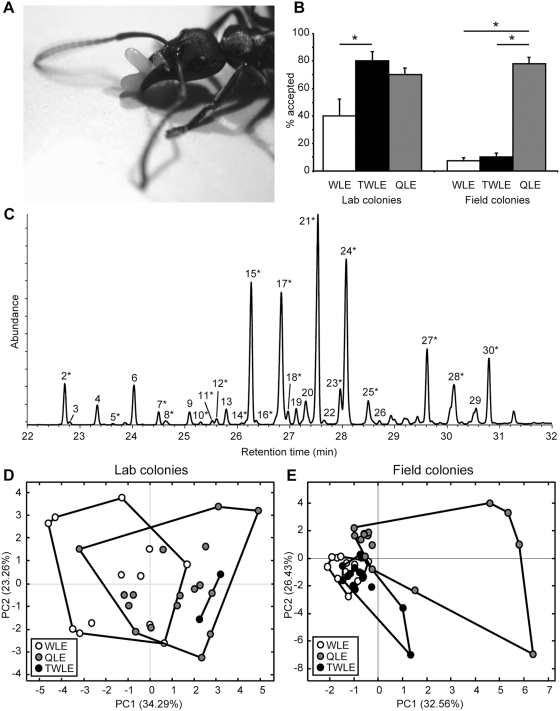
The effect of 3,11-diMeC27 on the acceptance of eggs in discriminator colonies and on the overall chemical profile.(A) A worker of Pachycondyla inversa carrying eggs. (Photo by M.A. Fürst and J.S. van Zweden). (B) The average acceptance rates in discriminator colonies (±S.E.) of sham-treated worker-laid eggs (WLE), worker-laid eggs treated with 3,11-diMeC27 (TWLE), and sham-treated queen-laid eggs (QLE) in lab and field colonies; * indicates p<0.05 (GLZ, see text). (C) A typical hydrocarbon profile of a Pachycondyla inversa egg: the 19 compounds marked with an asterisk were used in PCA models (see Methods); labels and compounds correspond to those in a previous study [17]: 2 = C25, 3 = unknown, 4 = 11-,13-MeC25, 5 = 5-MeC25, 6 = 3-MeC25, 7 = C26, 8 = 3,9-diMeC25, 9 = 10-,11-,12-MeC26, 10 = 6-MeC26, 11 = 4-MeC26, 12 = 2-MeC26, 13 = 3-MeC26, 14 = unknown, 15 = C27, 16 = 2,11-diMeC26, 17 = 9-,11-,13-MeC27, 18 = 7-MeC27, 19 = 5-MeC27, 20 = 9,13-diMeC27, 21 = 3-MeC27, 22 = 5,9-diMeC27, 23 = C28, 24 = 3,11-diMeC27, 25 = 10-,11-,12-,13-,14-MeC28, 26 = 6-MeC28, 27 = C29, 28 = 11-,13-,15-MeC29, 29 = 11,15-diMeC29, 30 = 3-MeC29. (D,E) Plots of the first two principal components showing the chemical similarity of the QLE and WLE and the predicted position of the TWLE.